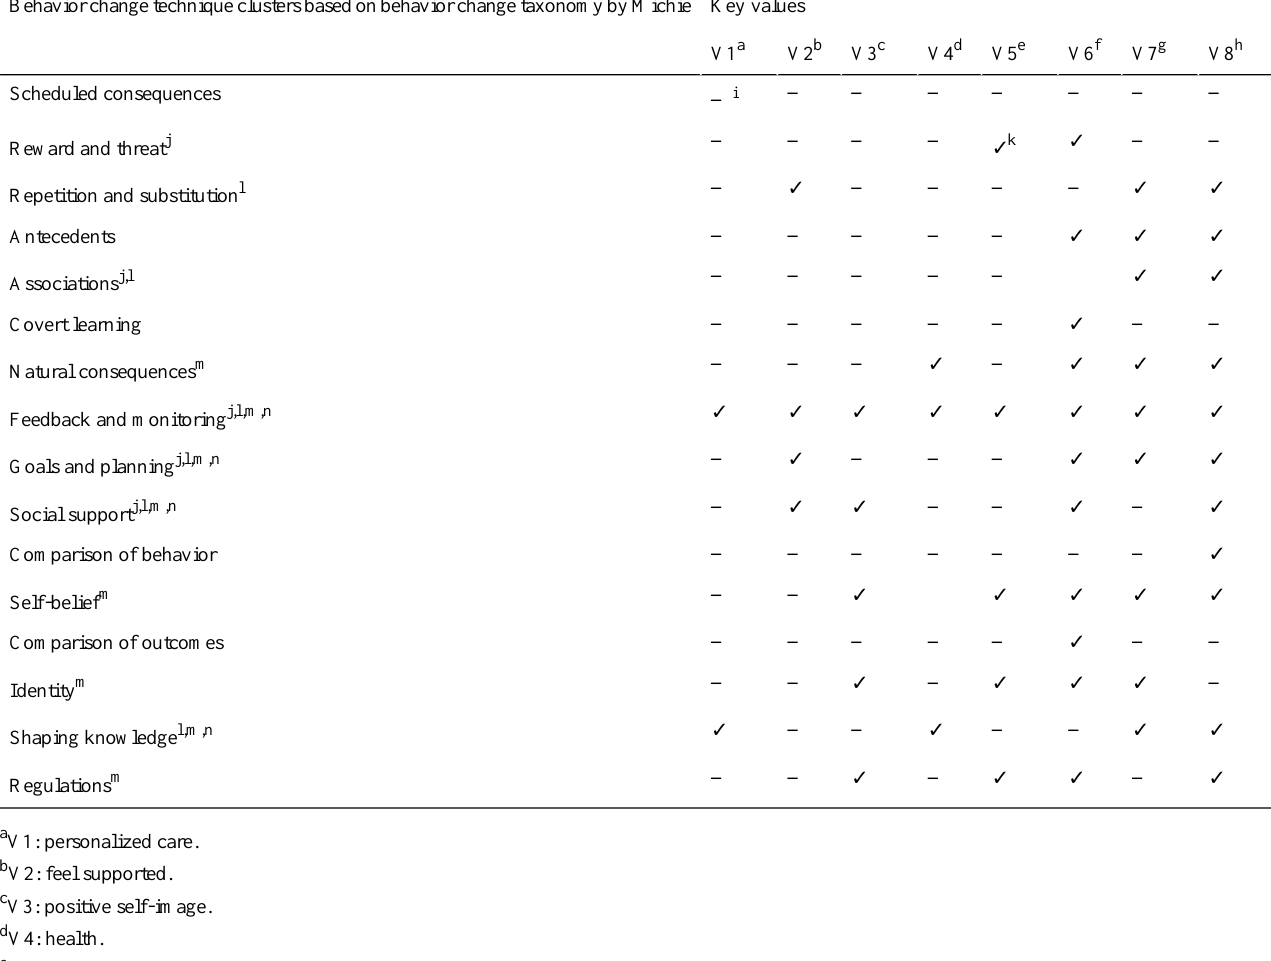
Table 3. Identified behavior change technique clusters supporting end user values.